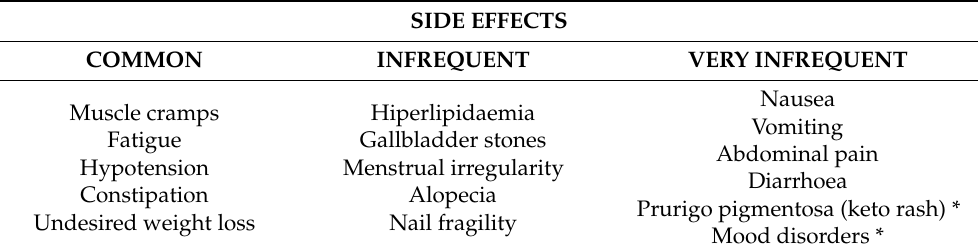
Table 4. Side effects of ketogenic diet. * Not directly observed by the authors in the patients they followed on the ketogenic